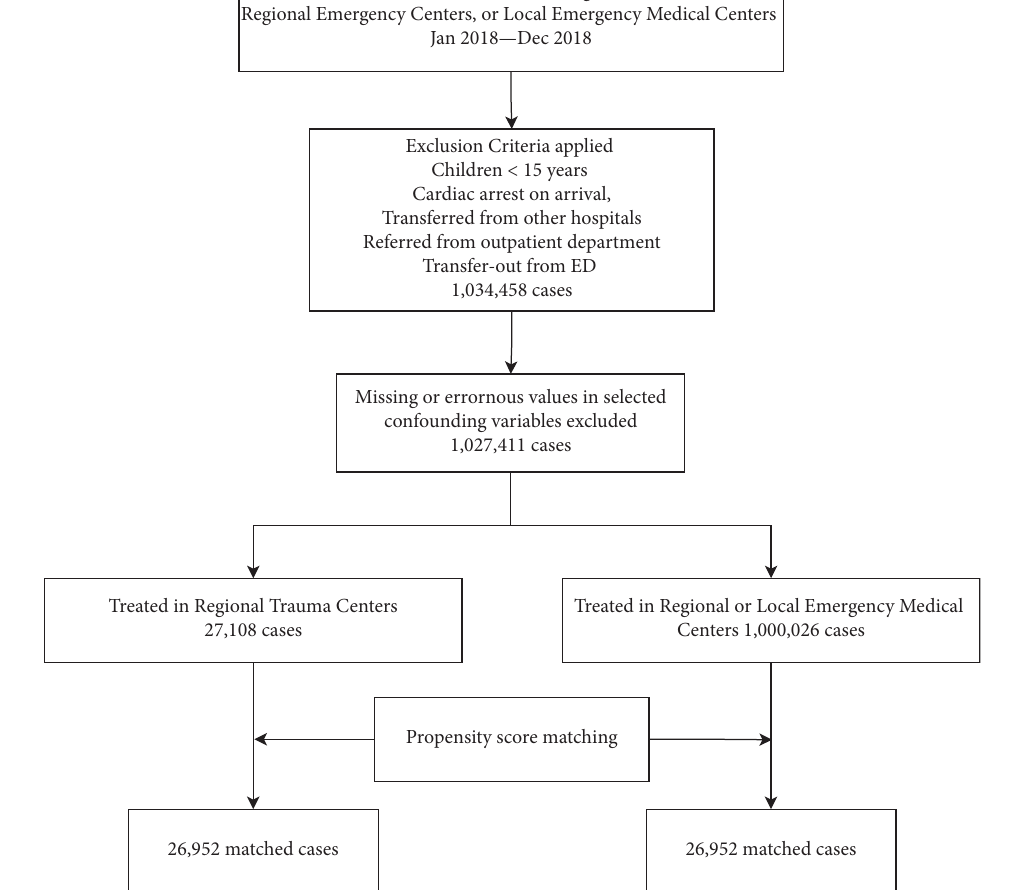
Figure 1: Flow diagram presenting the study population and cases matched for